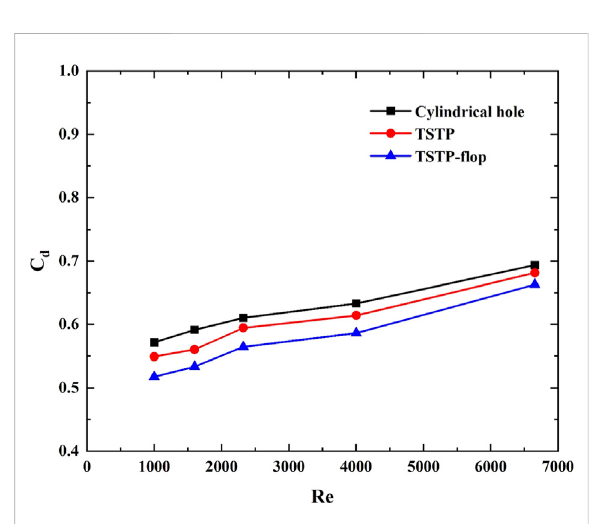
FIGURE 11 Comparison of discharge coef fi cient for the different cooling hole con fi